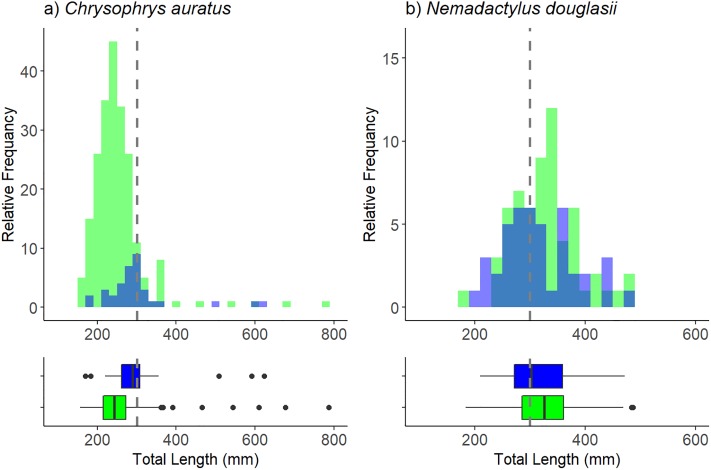
Lengths of two of the prominent fishery targeted species.a) the length distribution histogram for the total lengths of C. auratus at shallow (green) and mesophotic (blue) depths. A boxplot below summarises the distribution of total lengths for C. auratus at shallow (green) and mesophotic (blue) depths. b) The length distribution histogram for the total lengths of N. douglassi at shallow (green) and mesophotic (blue) depths. Boxplots below summarise the distribution of total lengths for N. douglassi at shallow (green) and mesophotic (blue) depths. The MLL for each species has been indicated by a dashed line on each plot.